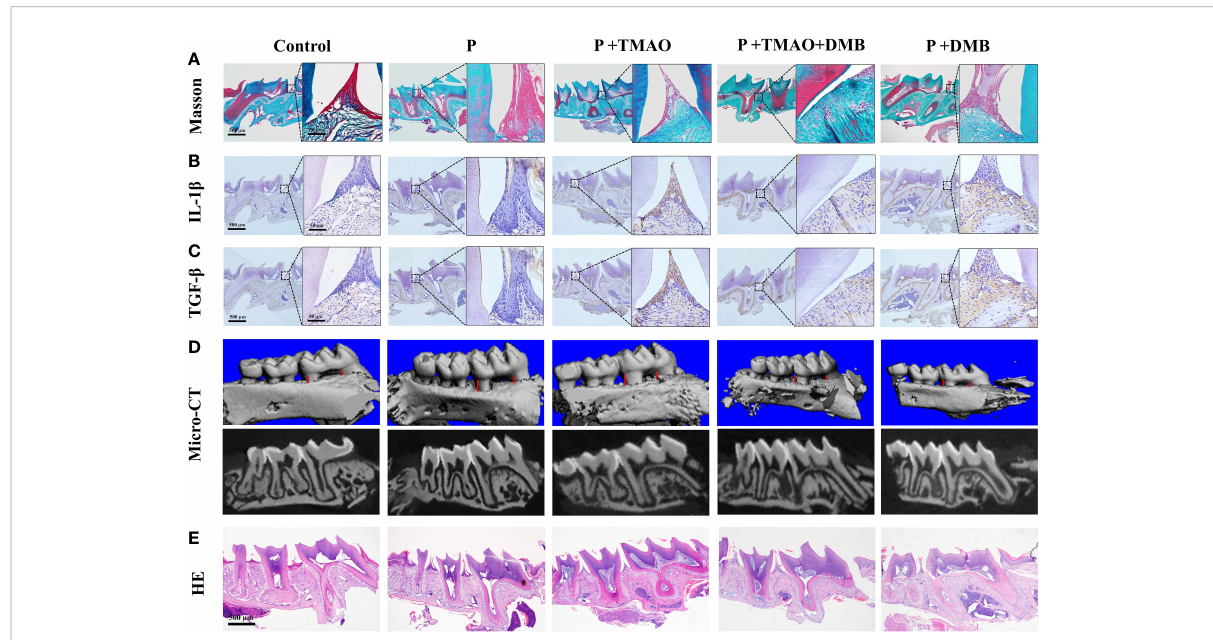
FIGURE 3 Changes of periodontal tissues and IL-1 b as well as TGF- b expression in every group. (A) Pictures of alveolar bone at the fi rst molars by Masson dyeing. Red is the gingival epithelium, and blue is the periodontal collagen fi bers. (B) Photographs of immunohistochemical staining of alveolar bone for IL-1 b . (C) Images of immunohistochemistry staining of alveolar bone for TGF- b . (D) Alveolar resorption at the interproximal sites of maxillary fi rst molars (buccal view) in a reconstruction from Micro – computed tomography (Micro CT) (red line). (E) HE staining of alveolar resorption at root furcation (black